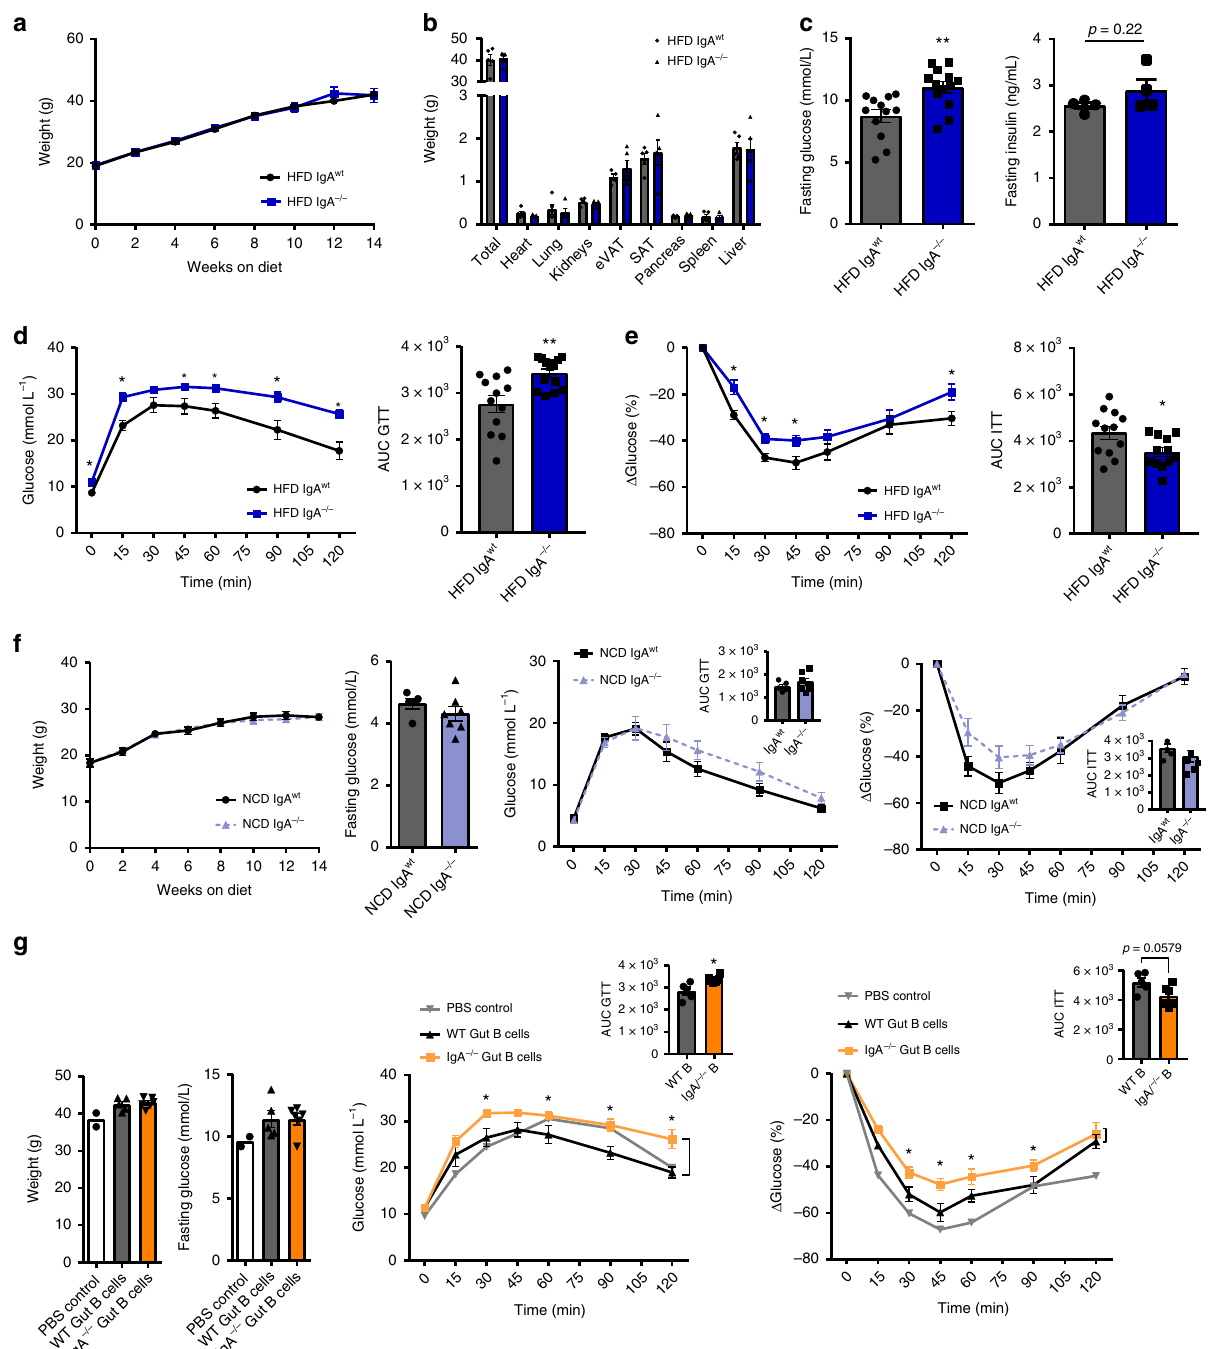
Fig. 3 Immunoglobulin A (IgA) de fi ciency, speci fi cally in intestinal B cells, increases insulin resistance in high fat diet (HFD)-fed mice. a Weight gain ( n = 21 WT, 16 IgA − / − HFD; 4 distinct cohorts) and b organ weights ( n = 5 WT, 5 IgA − / − ) of IgA − / − mice fed HFD compared to wild-type (WT) littermate controls over 14 weeks of diet. c Fasting glucose (left), fasting insulin (right) ( n = 4 WT, 4 IgA − / − ), d glucose tolerance test (GTT) (left) also represented by area under the curve (AUC) (right), and e insulin tolerance test (ITT) (left) also represented by AUC (right) in IgA − / − mice fed HFD ( n = 12 WT, 12 – 13 IgA − / − , 3 distinct cohorts). f Weight gain (left) ( n = 5 WT, 8 IgA − / − NCD), fasting glucose (middle left), glucose tolerance also represented by AUC (middle right), and insulin tolerance and AUC (right) of IgA − / − mice fed normal control diet (NCD) compared to WT littermate controls after 14 weeks of diet ( n = 5 WT, 7 IgA − / − NCD). g Weights (left), fasting glucose levels (left middle), blood concentrations of glucose during GTT and AUC (right middle), and ITT and AUC (right) of 12-week HFD-fed B cell-de fi cient muMT − (B null ) mice 2 weeks post adoptive transfer of IgA − / − or WT intestinal pan B cells, or a sham phosphate-buffered saline (PBS) control ( n = 2 PBS control, 5 WT gut B cells, 6 IgA − / − gut B cells). Data are means ± SEM. * denotes p < 0.05 and ** denotes p <